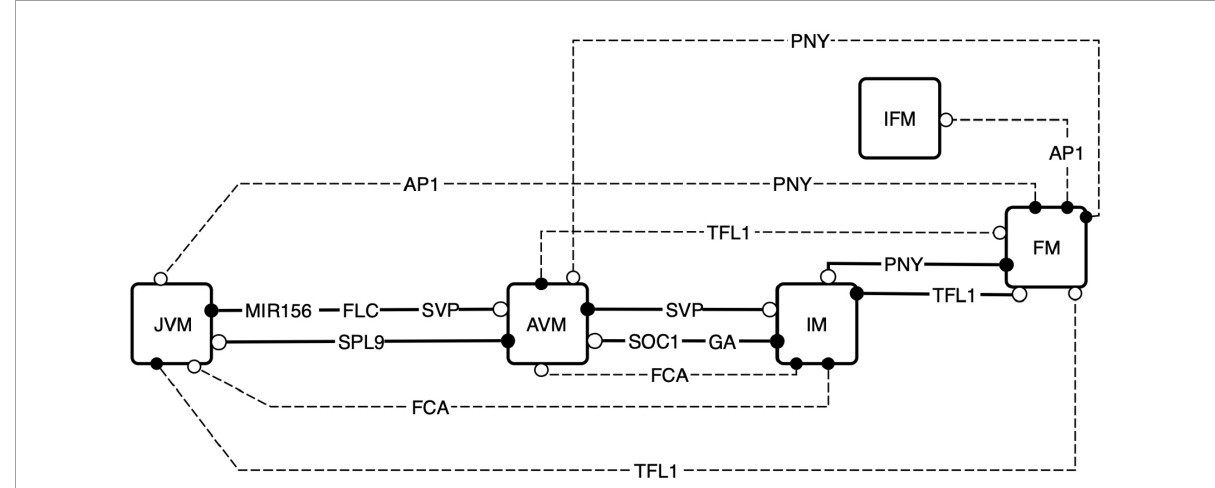
FIGURE8 Exploration of the attractors landscape uncovers the regulators that are sufficient for SAM phase transitions. By controlling the decay rates of the FT-GRN components, the attractors landscape is reshaped, and the states of the system can be driven to a contrasting phenotype. The FT-GRN components specified are those which drive changes when they decay faster in a continuous model, this effect is like a conditional gene silencing construct or protein inactivation inducing a phenotype transition. Continuous lines represent model predictions that agree with developmental observations, and discontinuous lines are predictions that have been documented under specific experimental conditions such as gene silencing. Black circles correspond to the initial meristem stage, and the white circles correspond to the final stage after the node was shut